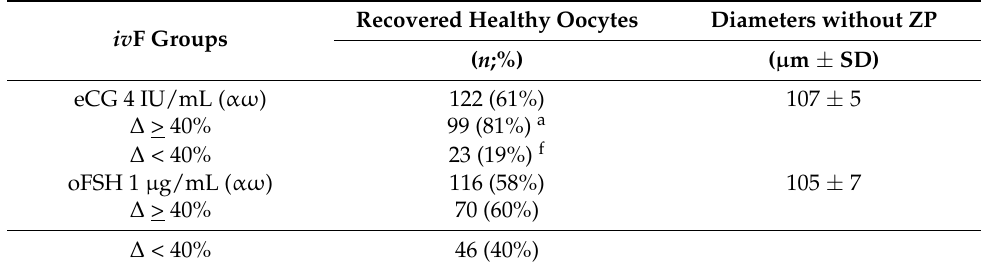
Table 4. Comparison of eCG and oFSH effect on growth and meiotic competence of oocytes isolated from iv F PA in FBS-supplemented